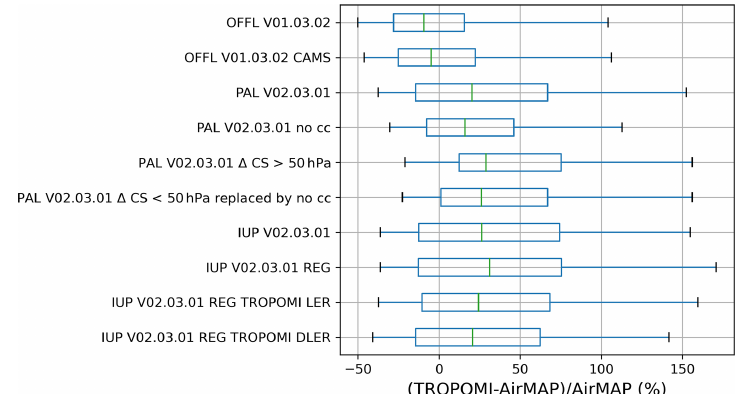
Figure A11. Box-and-whisker plots summarizing the bias and spread of the difference between the different TROPOMI versions and AirMAP tropospheric NO 2 VCDs. The green line inside the box represents the median relative difference. Box bounds mark the 25th and 75th percentiles, while the whiskers represent the 5th and 95th